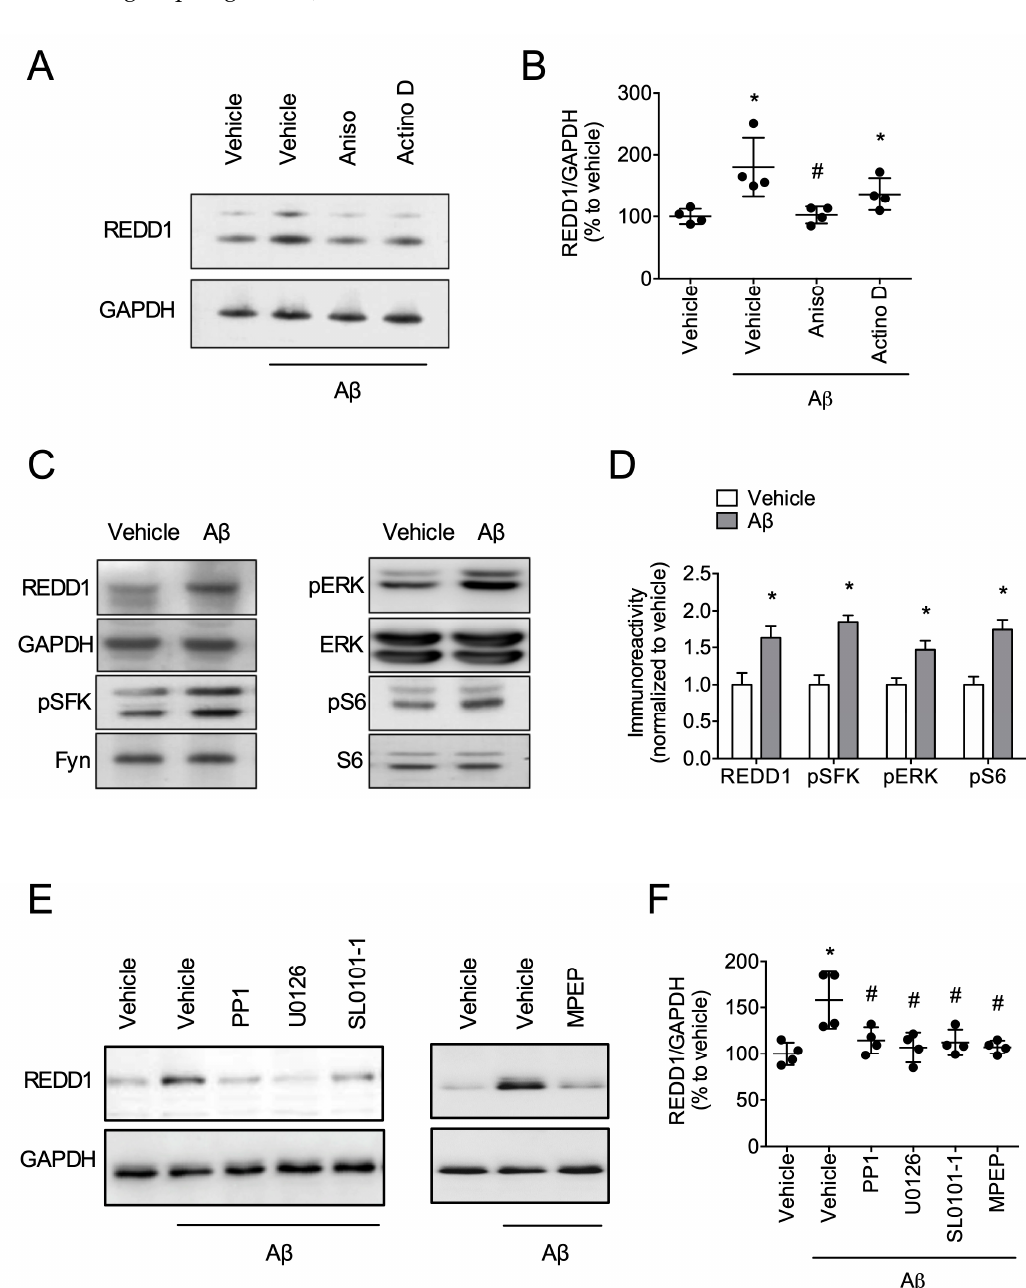
Figure 2. Fyn / ERK / S6 signaling is involved in A β -induced REDD1 translation. ( A , B ) A β increased REDD1 with translational modulation. Hippocampal slices were incubated with A β for 4 h with or without anisomycin (40 µ M) or actinomycin D (50 µ M). ( C , D ) A β activated Fyn / ERK / S6 signaling. Hippocampal slices were incubated with A β for 4 h. ( E , F ) Fyn / ERK / S6 signaling is required for A β -increased REDD1. Hippocampal slices were incubated with A β for 4 h with or without PP1 (10 µ M), U0126 (50 µ M), SL0101-1 (50 µ M), or MPEP (10 µ M). Data represented as mean ± SD with raw data. * p < 0.05 vs. vehicle-treated group. # p < 0.05 vs. A β -treated group.